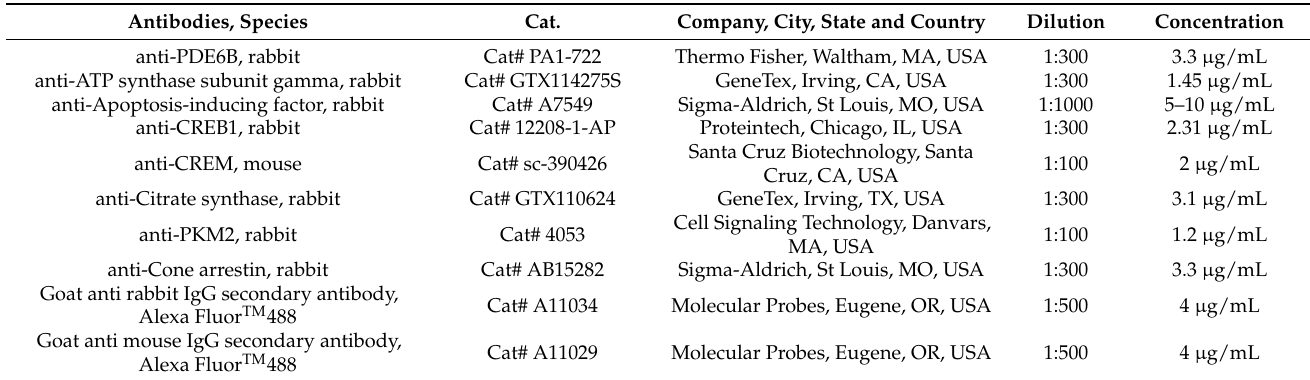
Table 1. Primary antibodies used in the